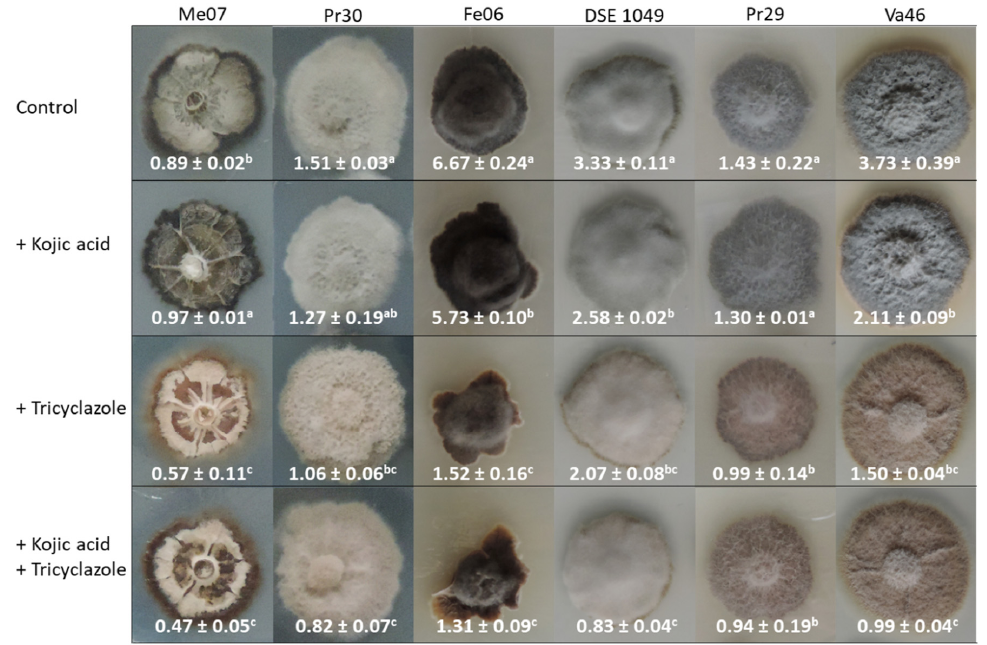
Figure 2. Accumulation of melanin in six DSE strains under control conditions or in the presence of inhibitors of melanin synthesis. DSEs were grown for two weeks on control Pachlewski medium or on the same medium amended with either 50 μ g/mL kojic acid or 10 μ g/mL tricyclazole, or a mixture of both inhibitors. A representative colony is shown and the experiment was carried out six times with similar results. Values represent melanin concentrations (mg/g DW) and are means ± SE. Significant differences between treatments ( p < 0.05, Kruskal–Wallis test) are indicated by different letters.